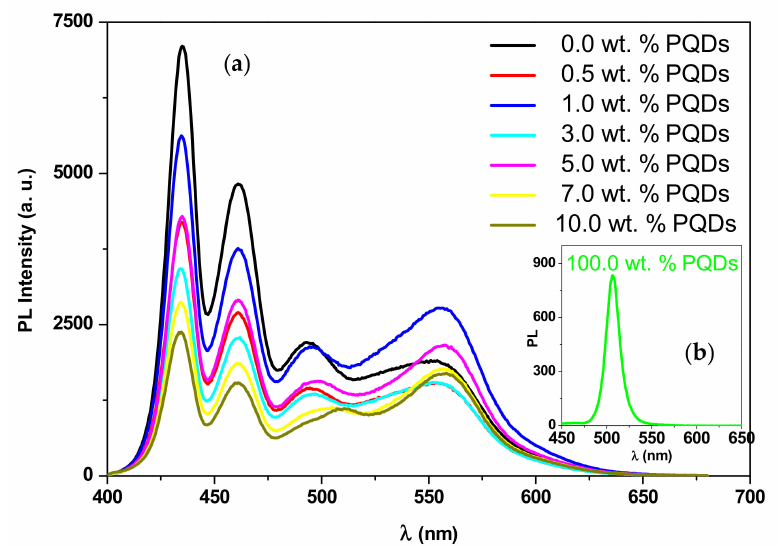
Figure 8. Photoluminescence (PL) spectra of the MEH–PPV/PFO hybrid containing various PQDs weight ratios ( a ). The inset is the PL spectrum of the pristine PQDs ( b